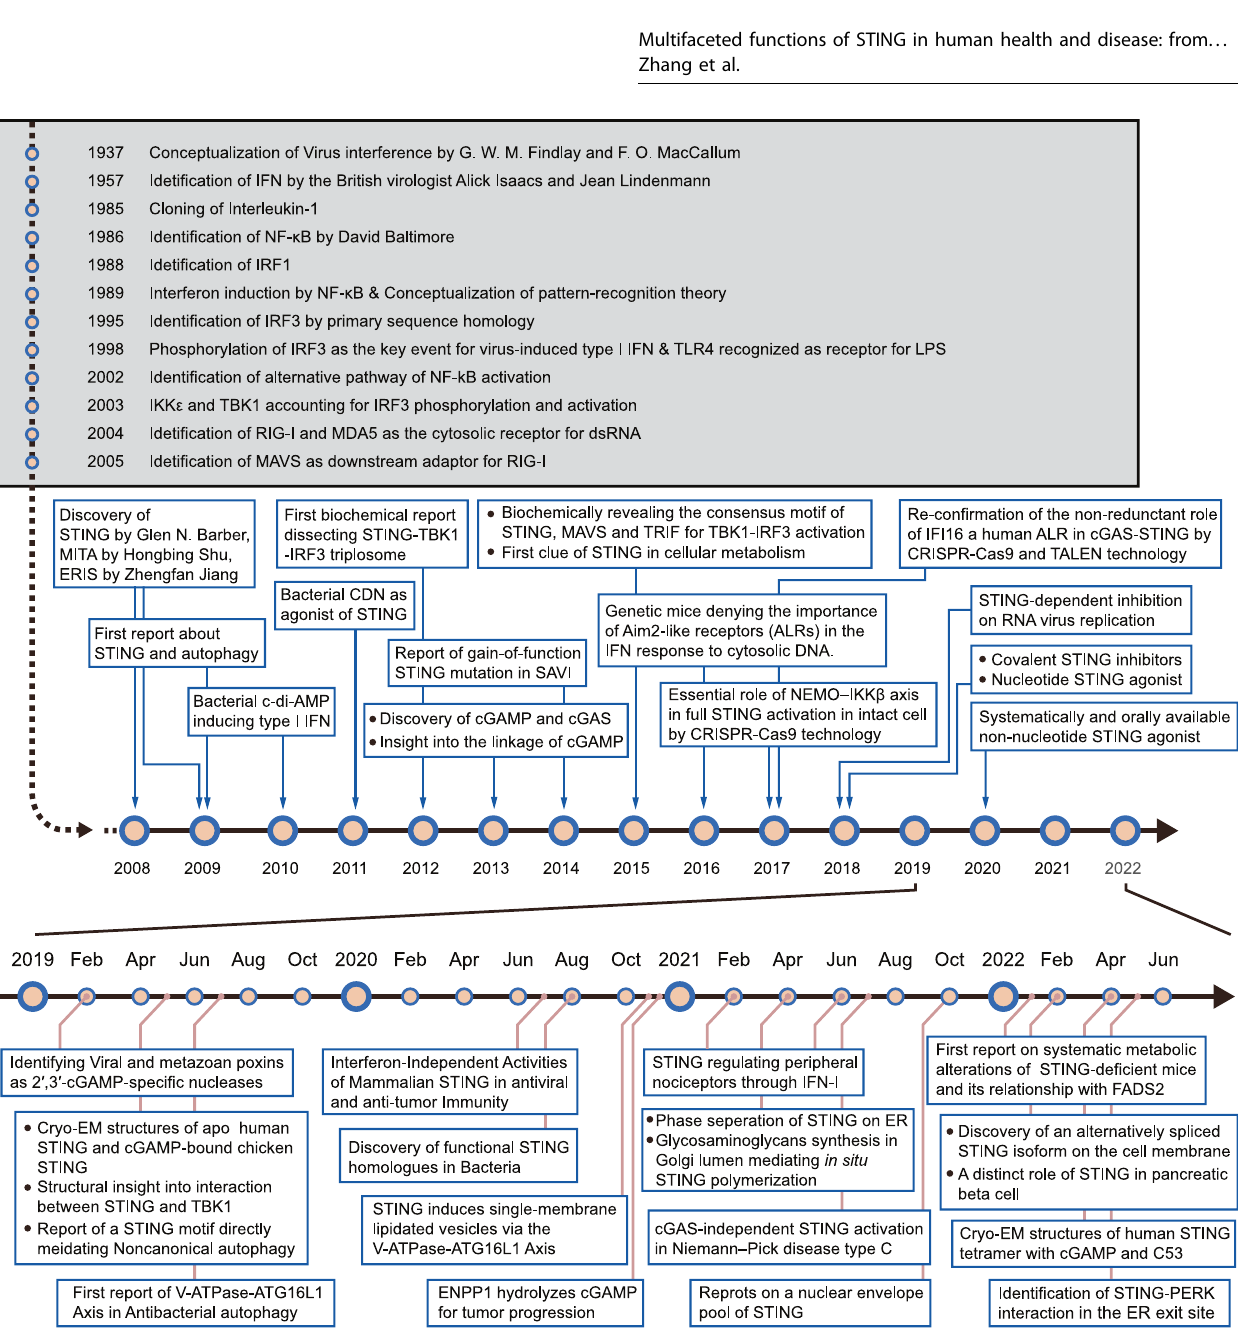
Fig. 1 Timeline depicting the brief history of interferon discovery and key events about STING biology since its identi fi cation in 2008. ATG16L1, autophagy-related 16 like 1; CDN cyclic dinucleotides, cGAMP cyclic GMP – AMP, CRISPR/Cas9 clustered regularly interspaced short palindromic repeats/CRISPR-associated protein 9, ENPP1 ectonucleotide pyrophosphatase/phosphodiesterase 1, ERIS endoplasmic reticulum IFN stimulator, IFN interferon, IRF1 interferon regulatory factor 1, IRF3 interferon regulatory factor 3, LPS lipopolysaccharide, MITA mediator of IRF3 activation, PERK PKR-like endoplasmic reticulum kinase, STING stimulator of interferon genes, TALEN transcription activator-like effector nucleases, TBK1 TANK-binding kinase 1, TLR4 Toll-like receptor 4, SAVI STING-associated vasculopathy with onset in